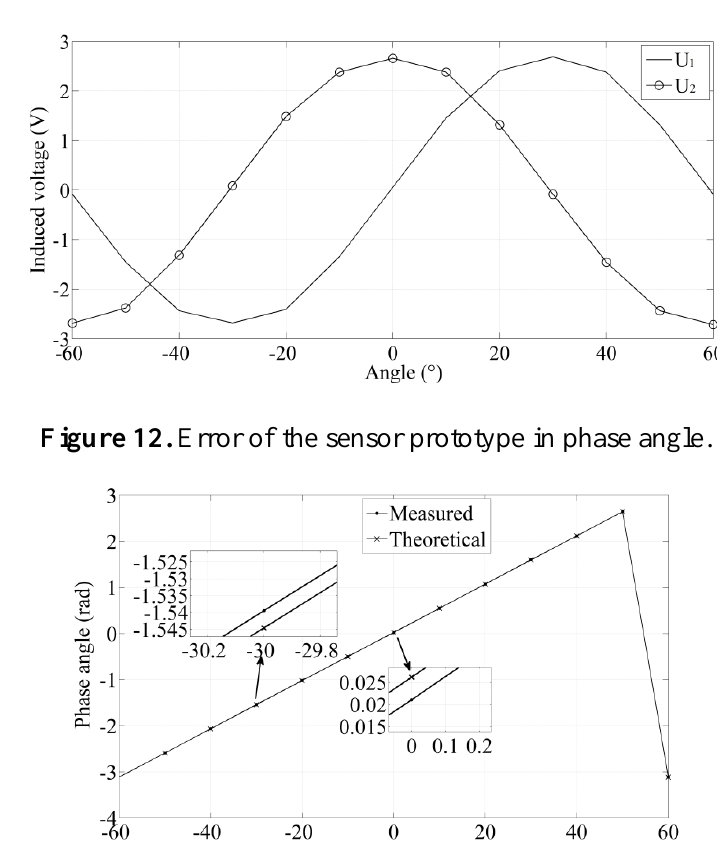
Figure 11. Demodulated signals in two receiving coils.